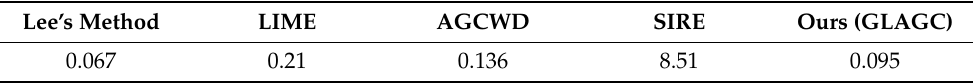
Table 2. Average computational time (unit: seconds) of the different methods. Lee’s Method LIME